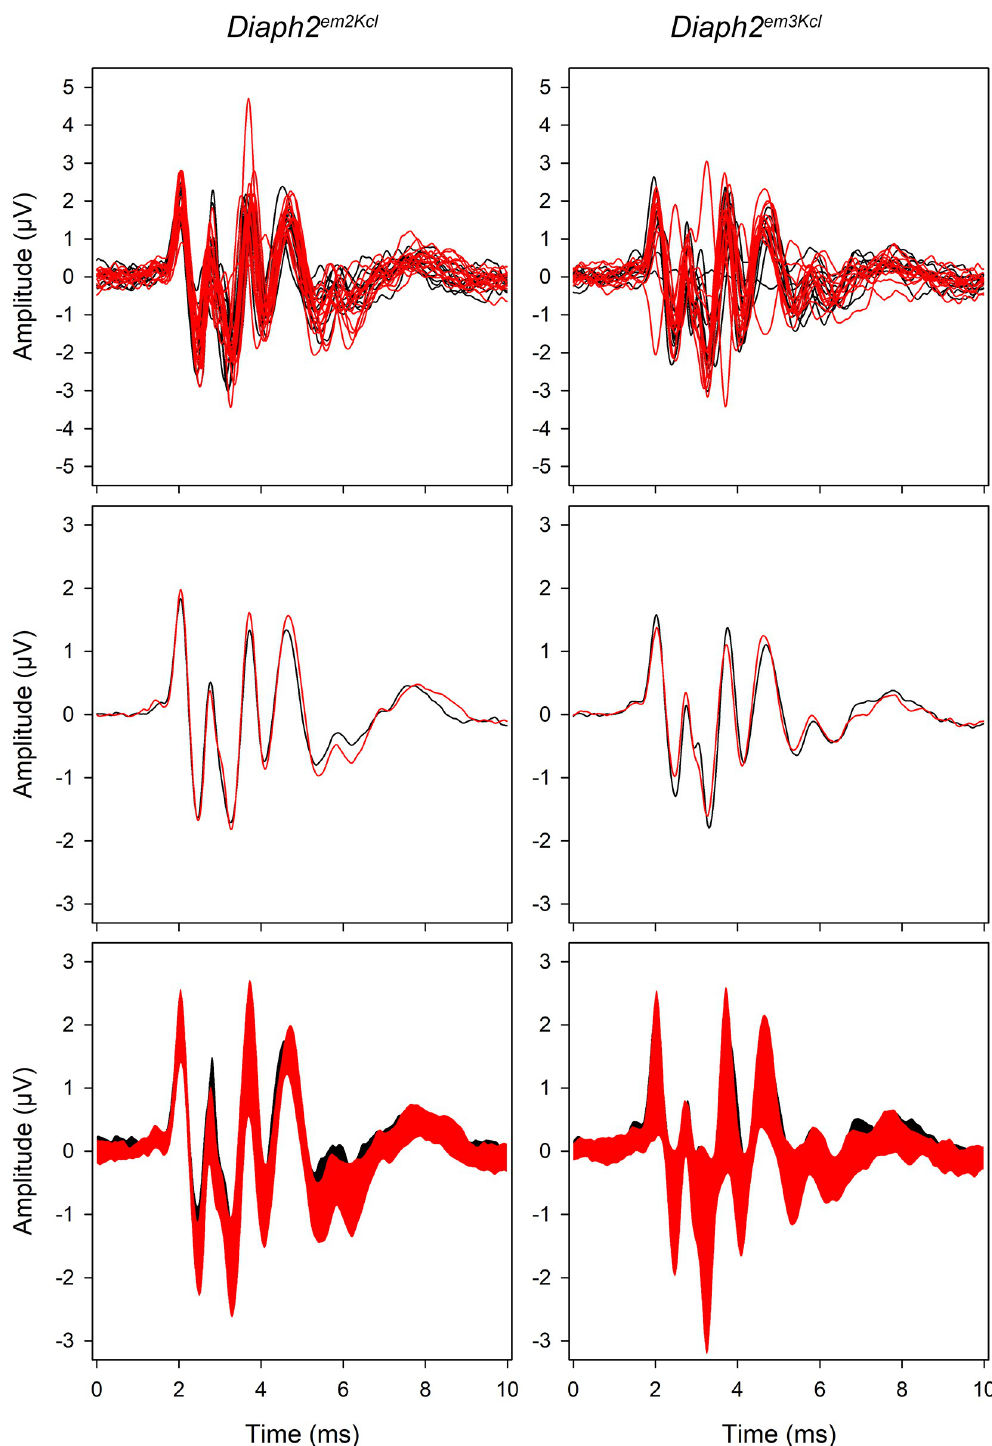
Fig 7. ABR waveform analysis in Diaph2 mutant mice. ABR waveforms in response to a click stimulus shown at 30dB above threshold (sensation level, SL) at fourteen weeks old. The top panels show individual waveforms, the central panels show the mean waveform, and the bottom panels show the mean ± standard deviation. There is no obvious difference between Diaph2 em2Kcl hemizygote and homozygote mice (red, n = 15) and wildtype mice (black, n = 10) (left), or between Diaph2 em3Kcl hemizygous and homozygous mice (red, n = 13) and wildtype mice (black, n = 10) (right).